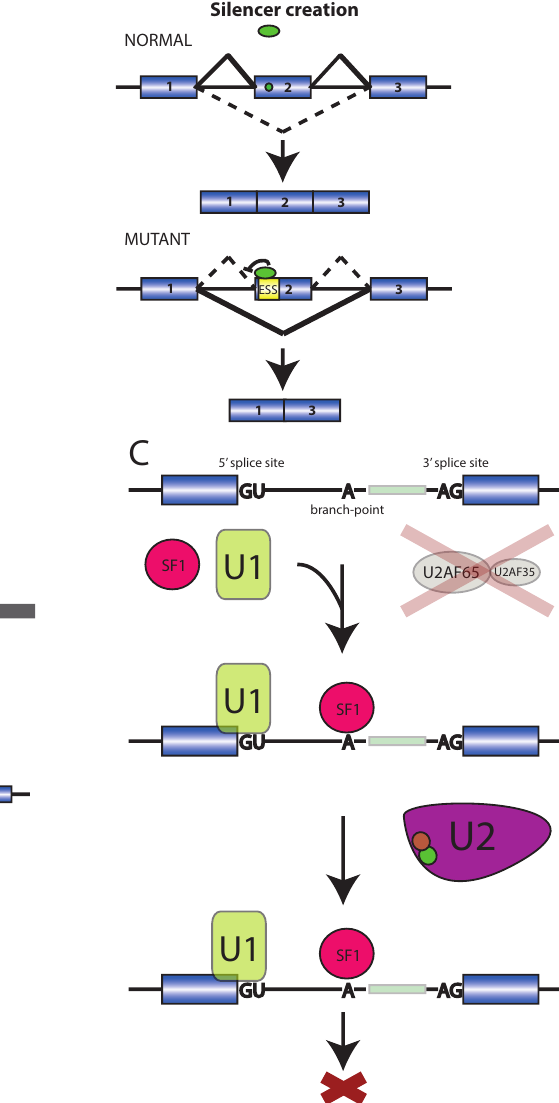
Figure 2. Three mechanisms of RBP-caused splicing dysregulation. ( A ) Disruption and/or creation of cis-elements by disease variants. ( B ) The RNA becomes toxic as a result of repeat expansion. Misregulation of splicing by the toxic RNA occurs through sponge-like titration of a splicing factor. ( C ) Mutation in splicing factor (e.g., U2AF) prevents it from binding to the pre-mRNA and stabilizing U2 snRNP. This results in unsuccessful transcript